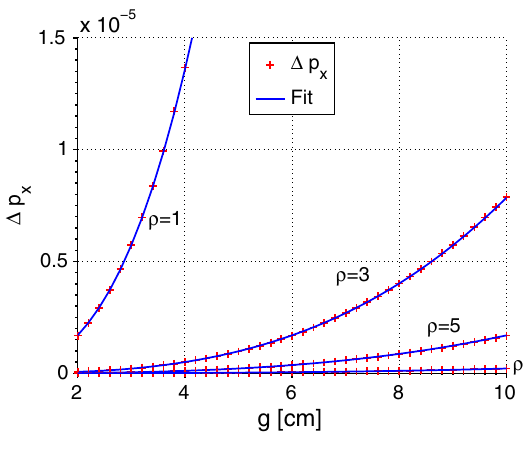
for the dipole exit. x; co